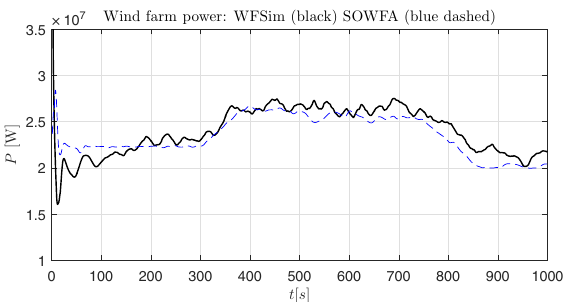
Figure 14. Wind farm power from SOWFA (blue dashed) and WF- Sim